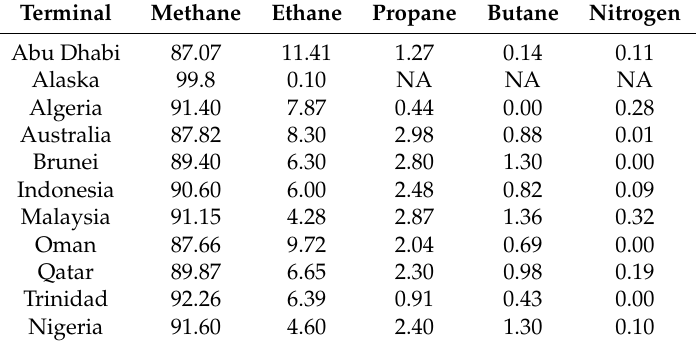
Table 2. Chemical compositions of LNG imported from various countries all over the world [42]. Terminal Methane Ethane Propane Butane Nitrogen Abu Dhabi